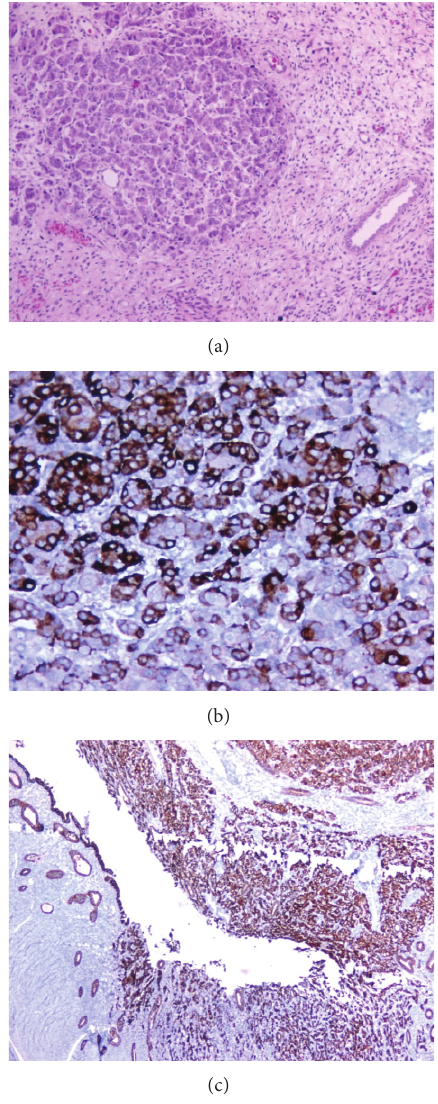
Figure 2: Pathological examination. Pathological microscopic examination demonstrating malign epithelial tumor cells ((a); hematoxylin-eosin, × 100), immunohistochemical staining positive for GCDFP-15 ((b); × 200), and pancytokeratin ((c); ×